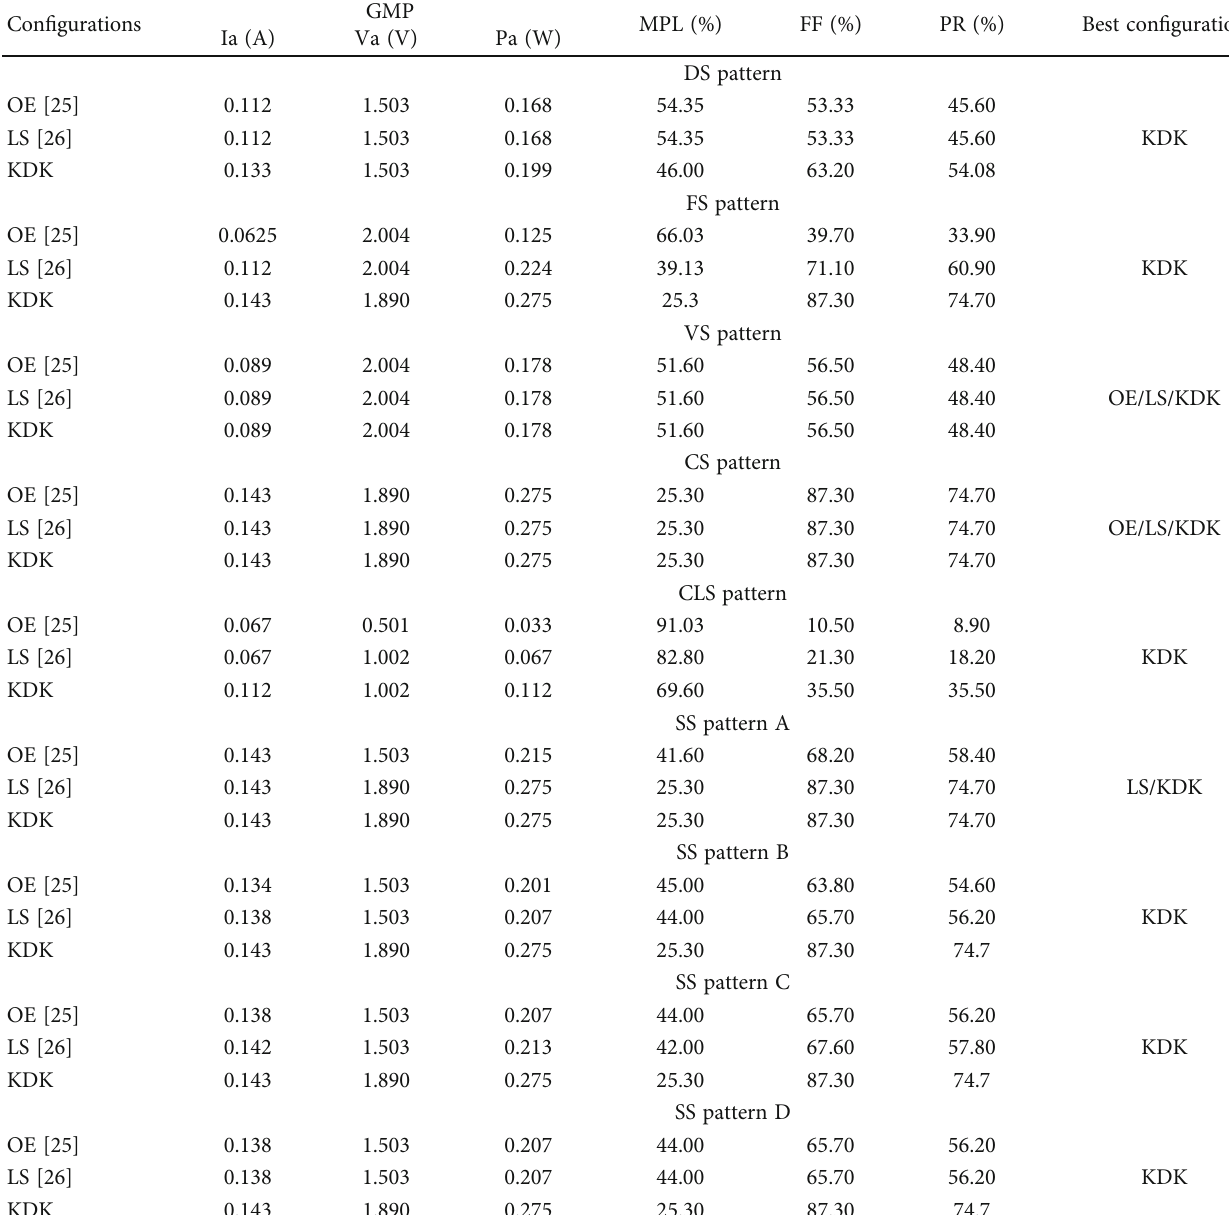
Table 3: Performance factors such as GMP, MPL, FF, and PR of OE [25], LS [26], and KDK arrangement schemes of con fi guration under di ff erent partial shading